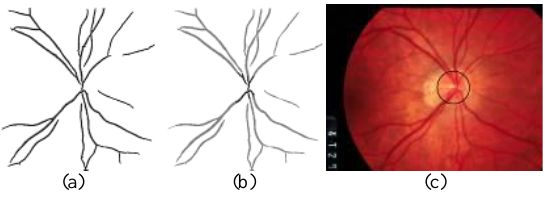
Figure 6. Results of different steps of obtaining initial optic disc circle. a) Extracted main vessel center line. b) Detected IOD vessels. c) Initial optic disc